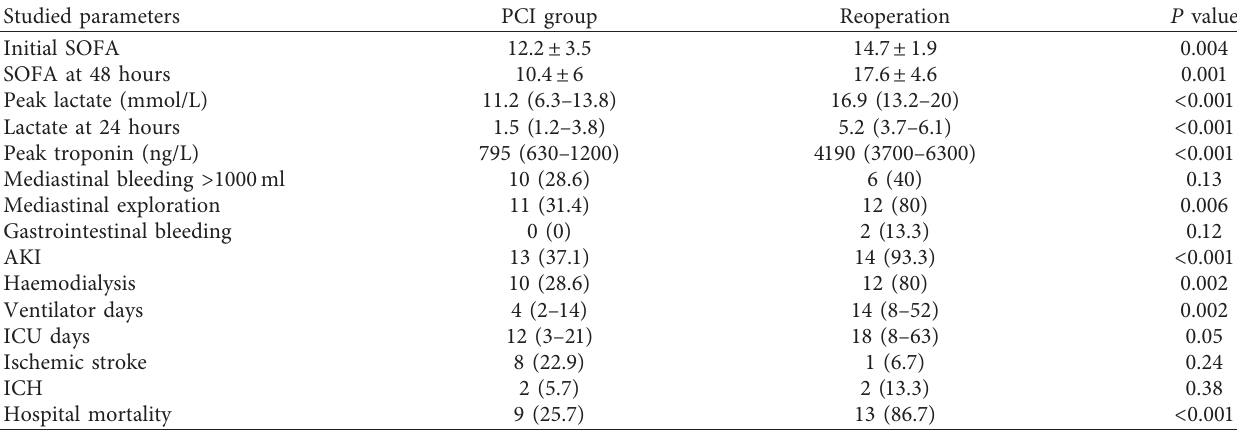
Table 5: Hospital outcome according to revascularization modality.